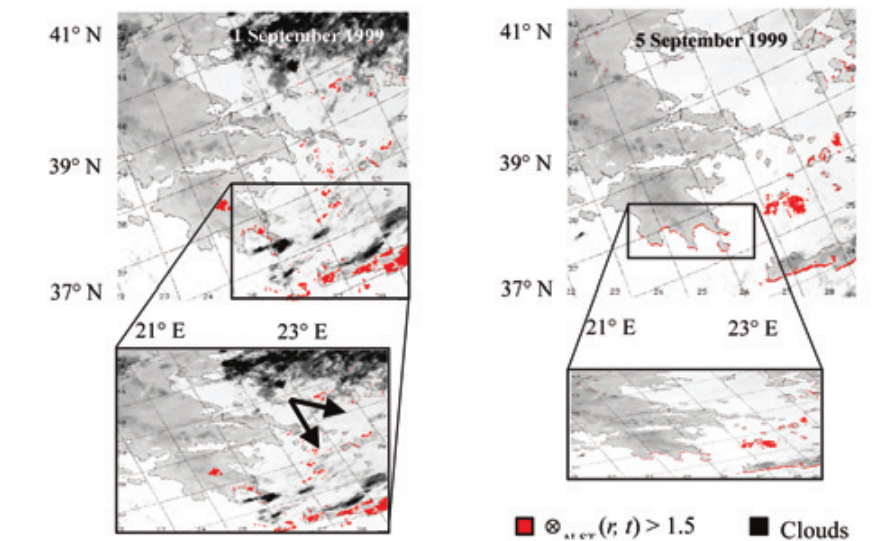
Fig. 6. Occurrence of non-persistent anomalies related to cloud passage (on the left ) and navigation errors (on the right ): the RST approach applied to polar satellite data (NOAA-AVHRR). Results of analysis of the daily ⊗ ∆ LST ( r, t ) index computation on the epicentral area of September 7th 1999 Athens’s earthquake. The black ar- rows indicate the cloud system which is probably responsible for the anomalous patterns, of similar shape, af- fecting Crete island. In the right image, spurious effects due to wrong co-location are quite evident along South- ern coasts of Peloponnesus and Crete (adapted from Filizzola et al. , 2004)